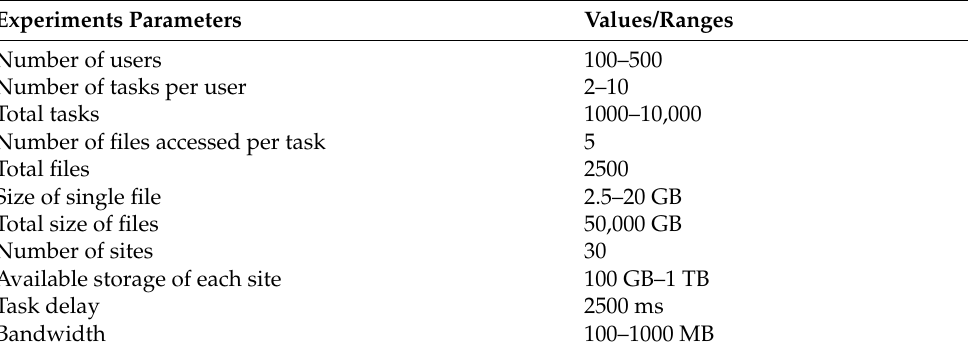
Table 2. Simulation Environment Configurations.